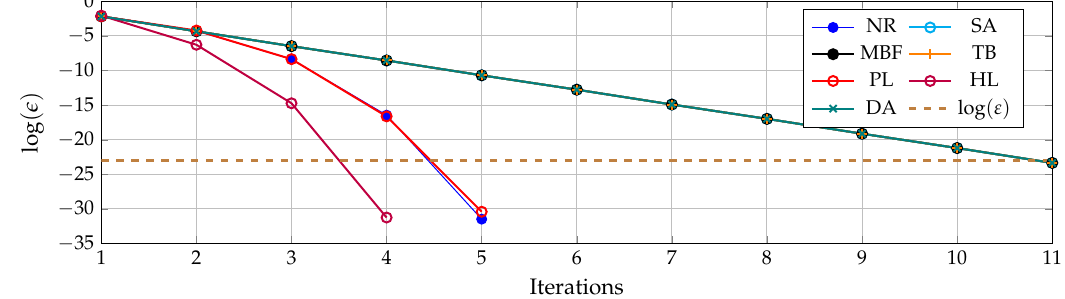
Figure 5. Convergence performance of the studied methods in the IEEE 85-bus system.